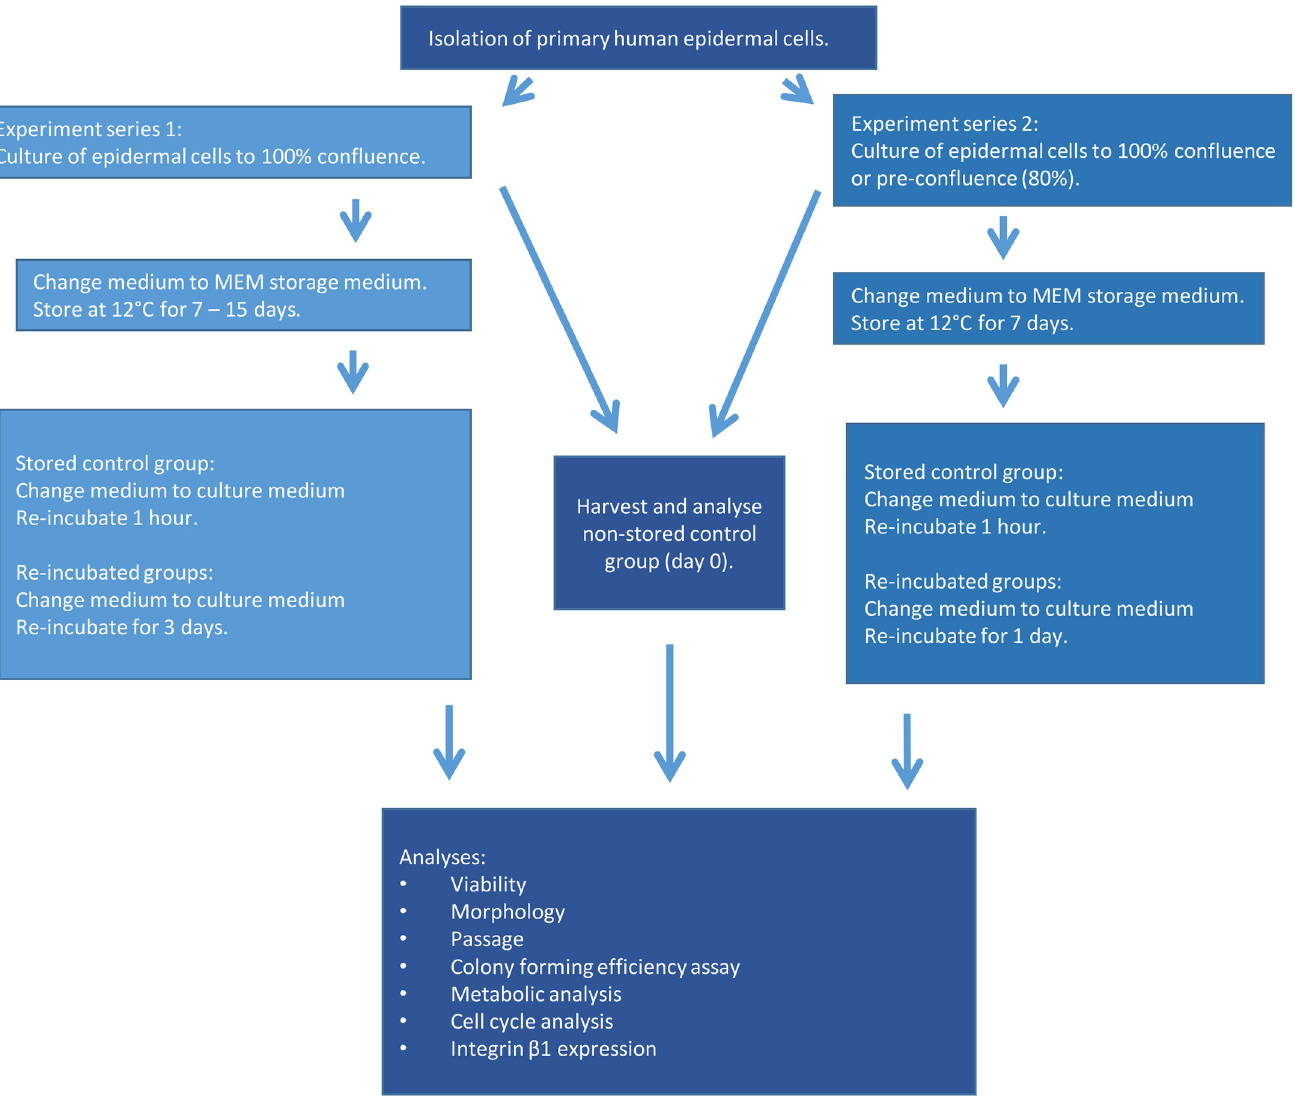
Fig 1. Chart illustrating workflow of the two experimental series and the analyses performed.